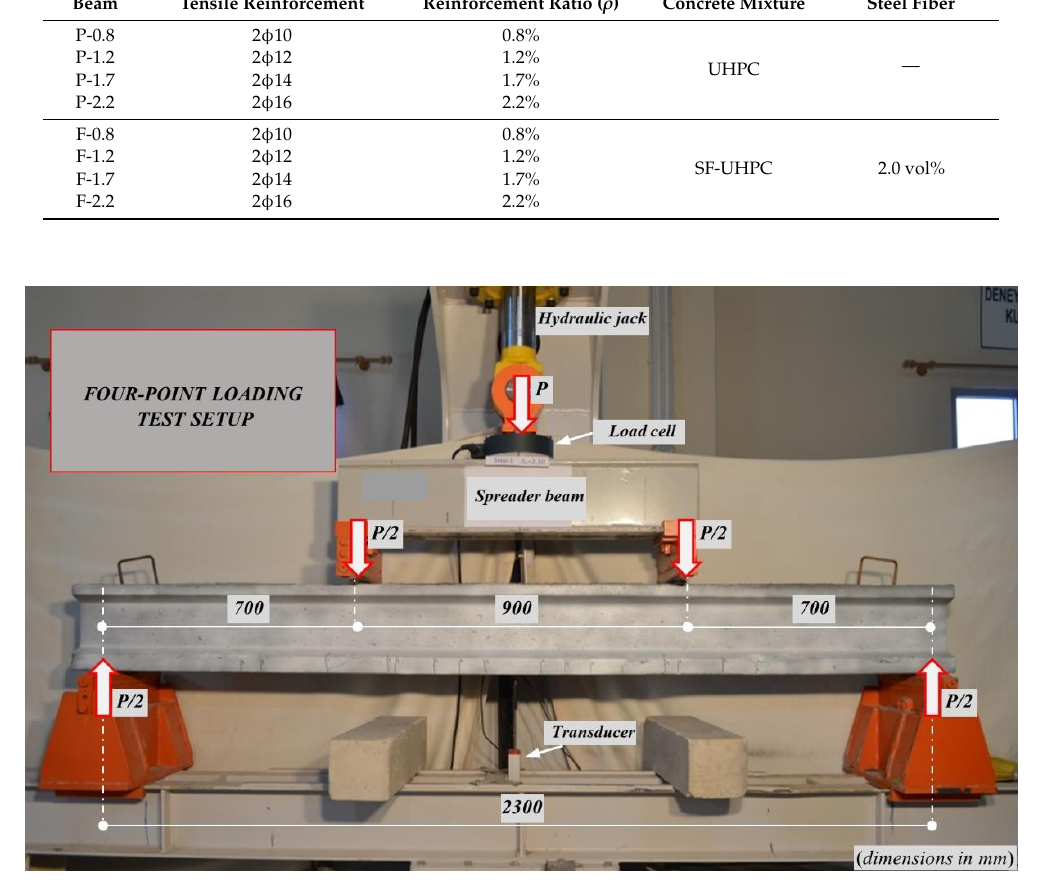
Table 2. Reinforcement and concrete contents of test beams.